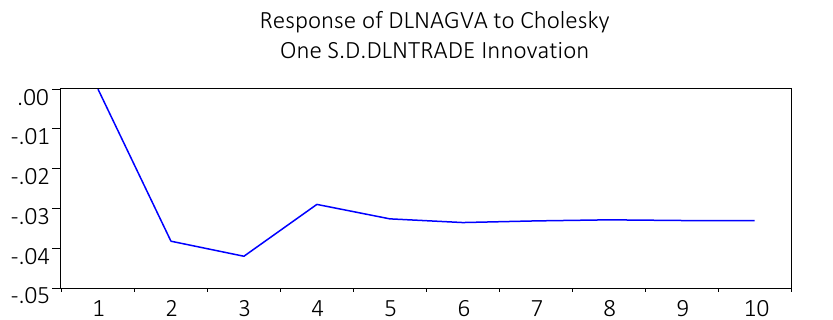
Figure 2c. Regional integration policy response on agricultural development by 2030 (SDG agenda) in West Africa